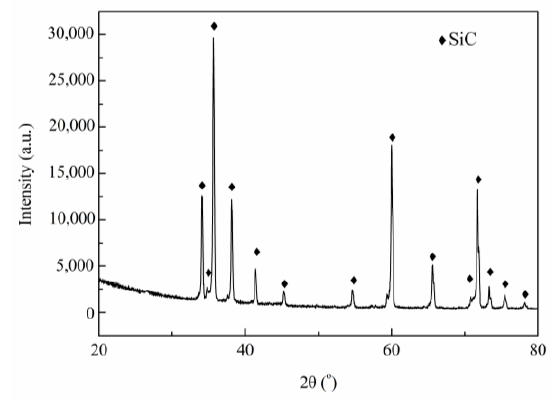
Figure 1. XRD pattern of SiC porous ceramics.